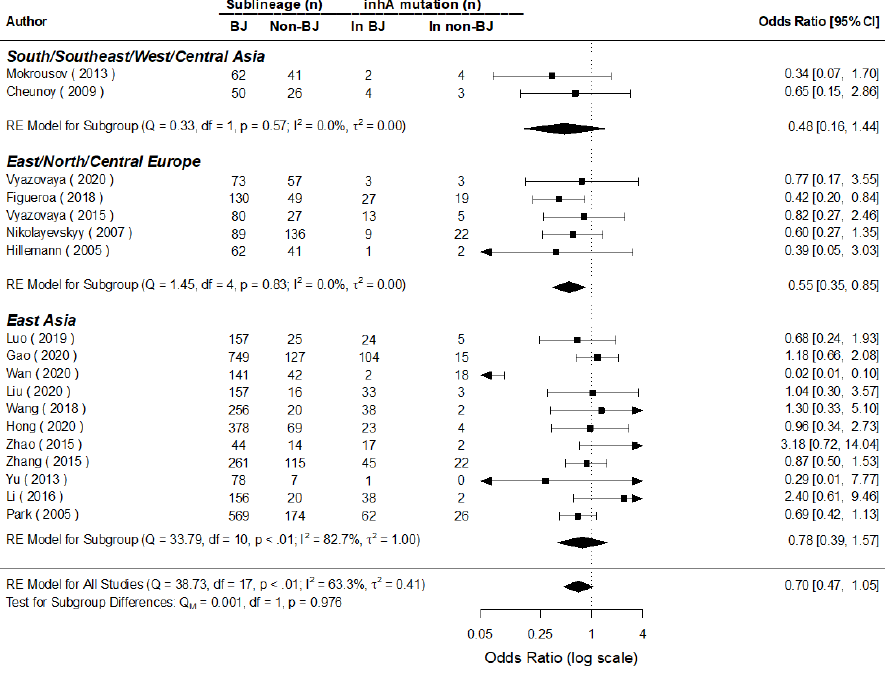
Figure 8. MA for the mutations of inhA in Beijing and non-Beijing strains (CI: confidence interval; BJ: Beijing strain; Non-BJ: non-Beijing strain). The pooled posterior value of OR for the mutations of oxyR-ahpC (100% mutated in oxyR-ahpC intergenic region) was [1/exp (log-0.38)] = 1.46 (95% CI: 1/exp (log0.14) = 0.87, 1/exp (log-0.91) = 2.48) times higher in the non-Beijing than in the Beijing strains for all nine studies included that evaluated the mutations of oxyR-ahpC , without any statistical significances found, neither in BMA nor in MA (OR = 1.45, 95% CI: 0.94, 2.22). A homoge- neity ( I 2 = 0.0%) and a prediction interval for the effect as 1.46 (95% CI: 0.59, 3.71) were found for the seventh in a future study were identified (Figures 9 and 10).